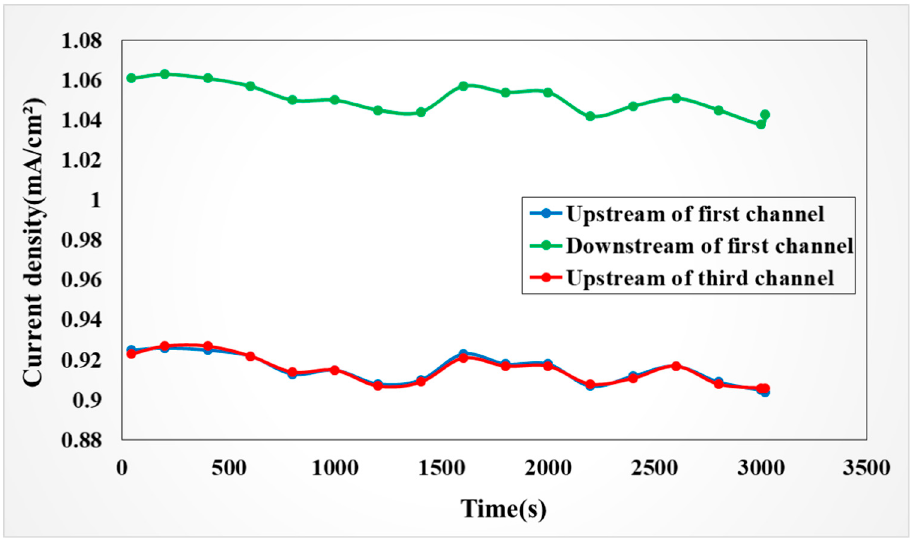
Figure 17. Current density in anode of battery in 40 mA/cm 2 constant current charging process.